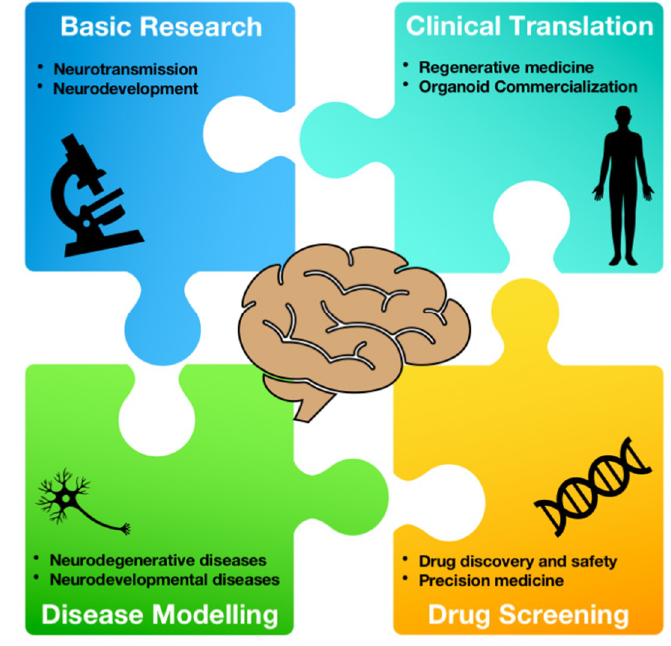
Figure 3. Potential applications for organoid research. The obtainment of human-derived organoids allows for a comprehensive understanding of neurological disorders. Their use in basic research allows for studies investigating the brain’s structure and connections. Moreover, their role in disease modelling will allow for the investigation of potential alterations in cerebral organoids derived from patients with neurodegenerative or neurodevelopmental diseases. They will provide a useful platform for drug screening, and will lead the way to precision medicine approaches, allowing for a more directed and safe clinical translation.